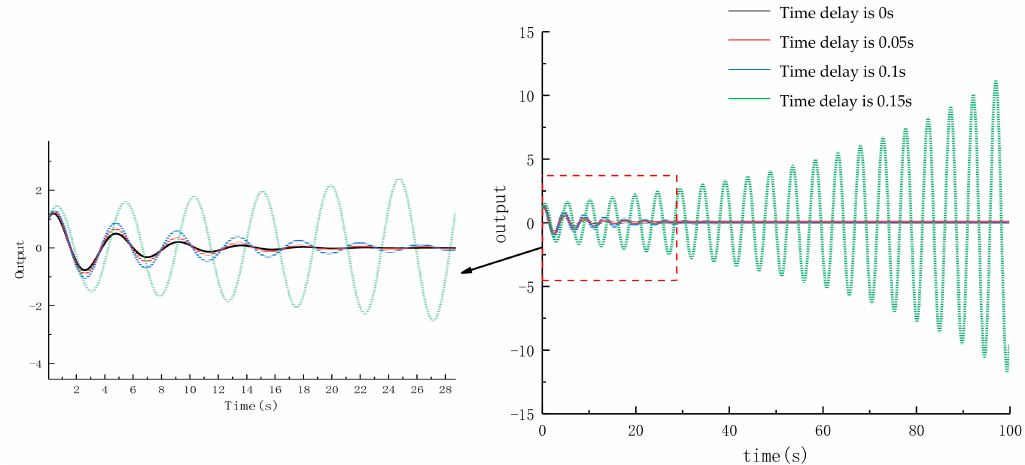
Figure 2. Comparison of system response curves under different time